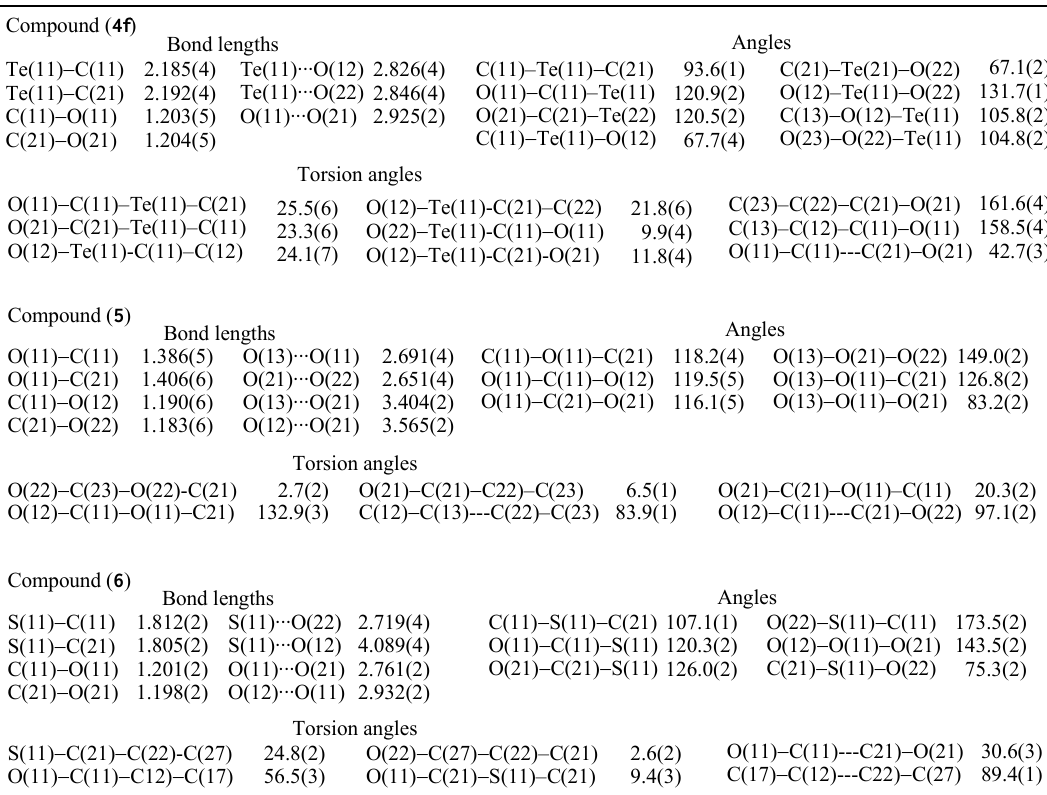
Table 2. Selected bond distances (A), angles ( o ) and torsion angles ( o ) of bis(2-methoxy- benzoyl) telluride ( 4f ), 2-methoxybenzoic anhyride ( 5 ) and bis(2-methoxybenzoyl) sulfide ( 6